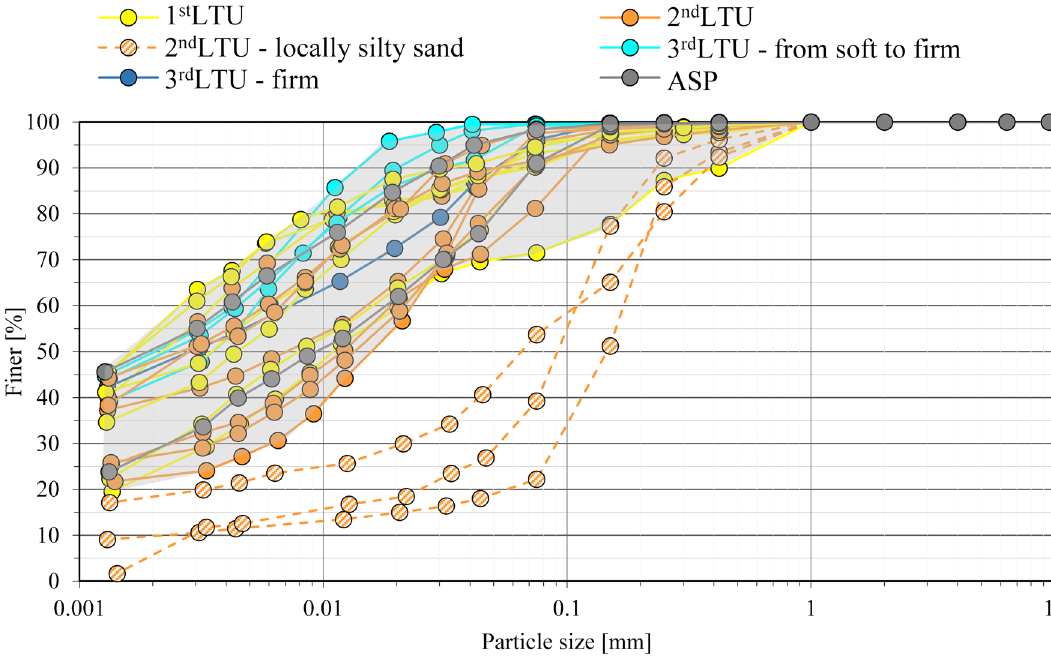
Figure 8. Grading curves of the Mar Piccolo sediment samples collected within different LTUs (S1, S2, S3, S4, S6, S7 sites of section N–N ′ in Fig.